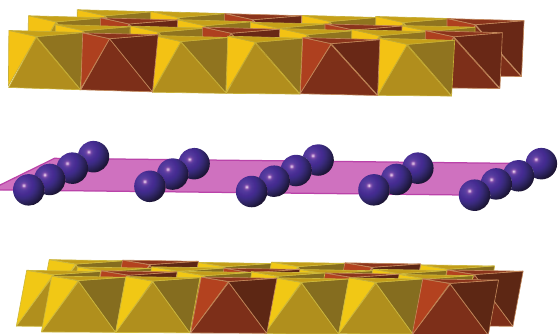
Figure 2: Layered structure of birnessite.